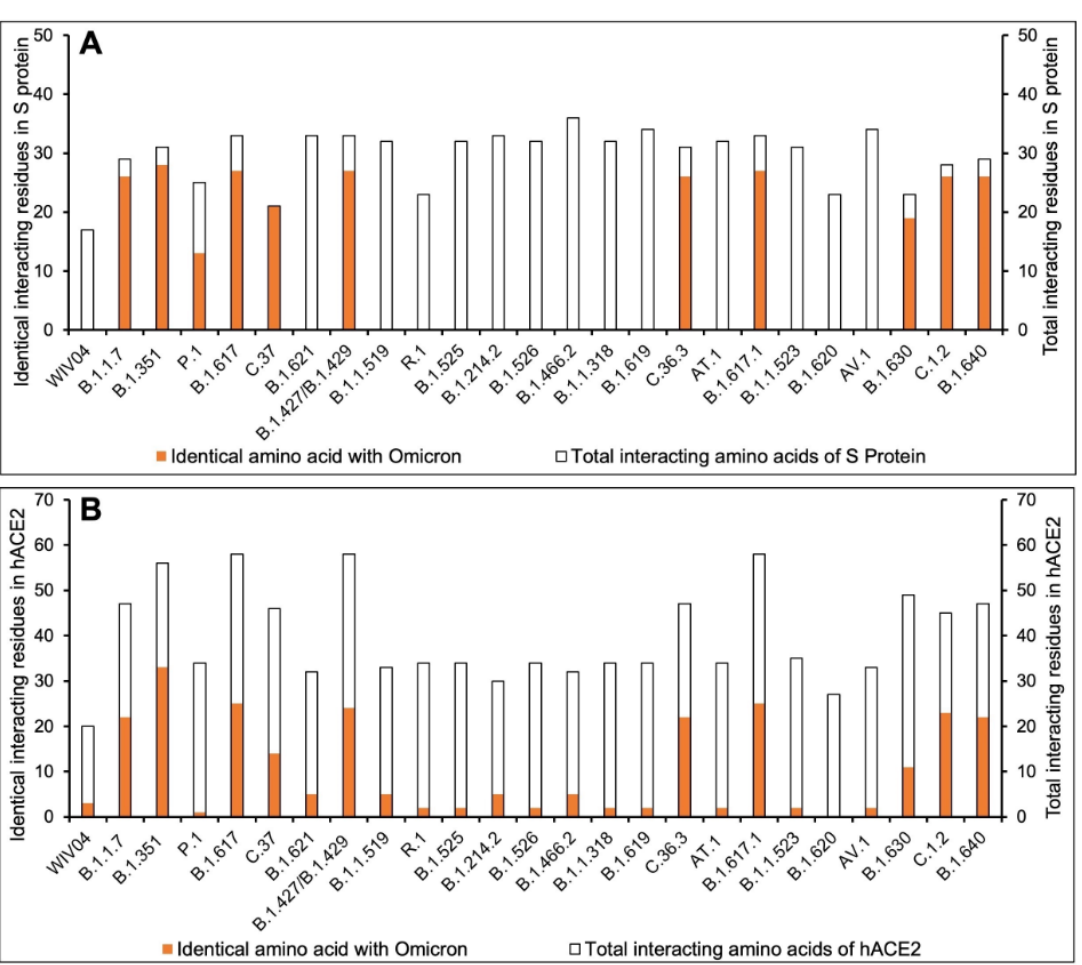
Figure 1: Comparative interacting residues of (A) RBD of SARS-CoV-2 variants and (B) hACE2 with respect of the Omicron variant. The protein-protein interaction between hACE2 and SARS-CoV- 2 RBD was studied by performing molecular docking using ClusPro server (https://cluspro.org) and an- alyzed in PDBSum. The number of interacting residues were calculated and identical residues to that of the Omicron variant were